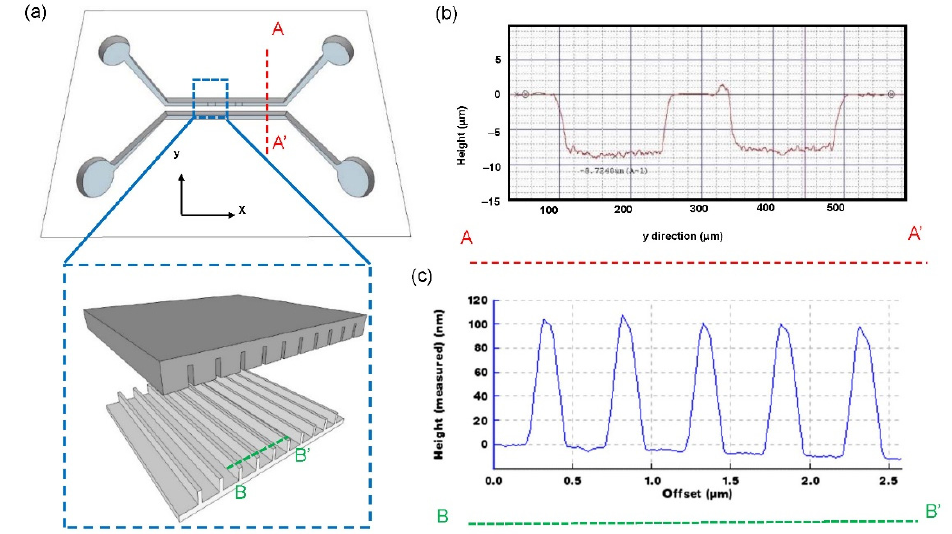
Figure 2. Surface profile of the microstructure and nanostructure. ( a ) Schematics of the microflu- idic devices. The profiles of ( b ) microstructure and ( c ) nanostructure were measured.